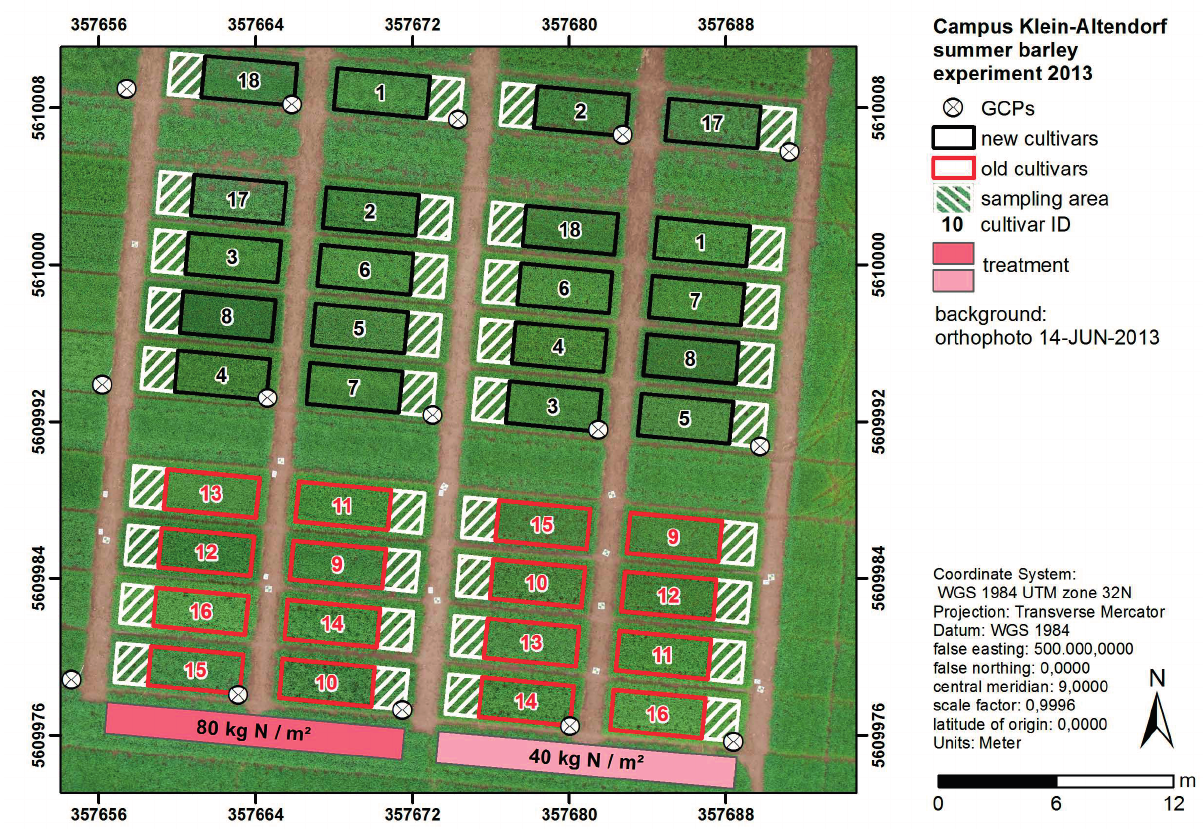
Figure 1. Test site: summer barley experiment at Campus Klein-Altendorf agricultural research station in 2013. GCPs, ground control points used for crop surface model (CSM)